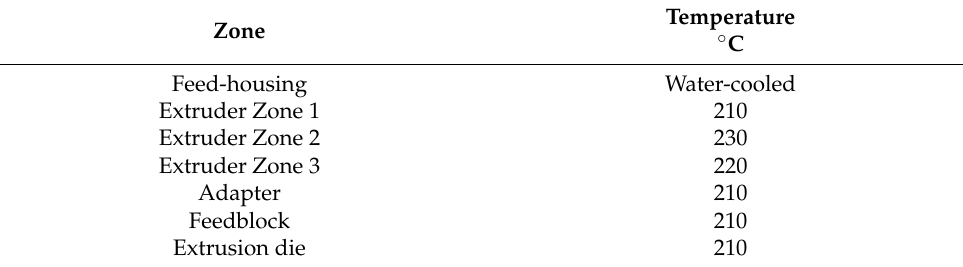
Table 3. Temperature settings of extruders, feedblock, and extrusion die.